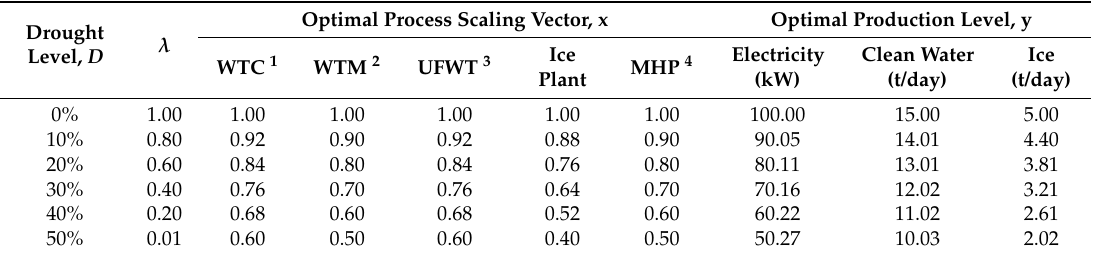
Table 2. The resulting process capacity factor and the optimal production level for case study 1.